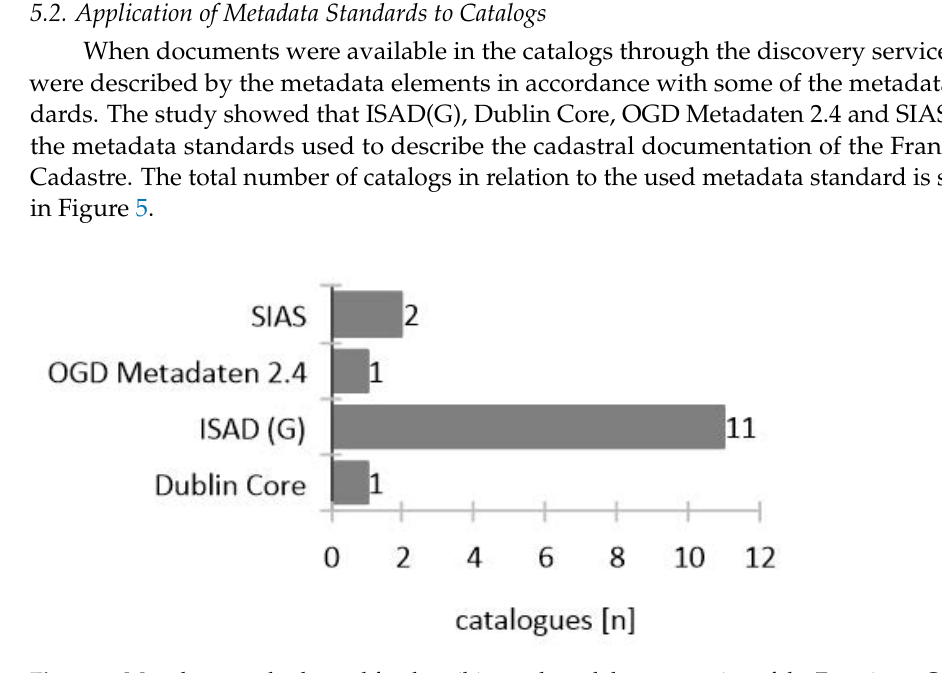
Figure 5. Metadata standards used for describing cadastral documentation of the Franciscan Cadastre in catalogs. Source: Own compilation.